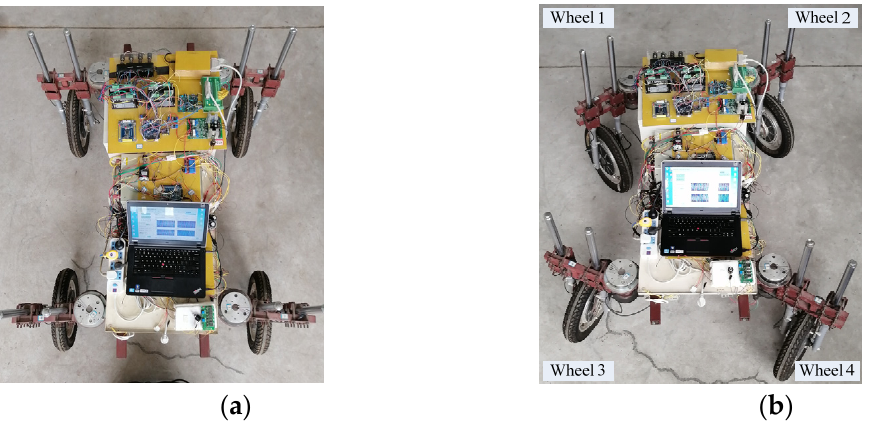
Figure 9. Test scenes of the four-wheel-steering MMS: ( a ) Preparation mode; ( b ) Four-wheel steering. Table 4. Comparisons of MMS effects under optimized and unoptimized control parameters.